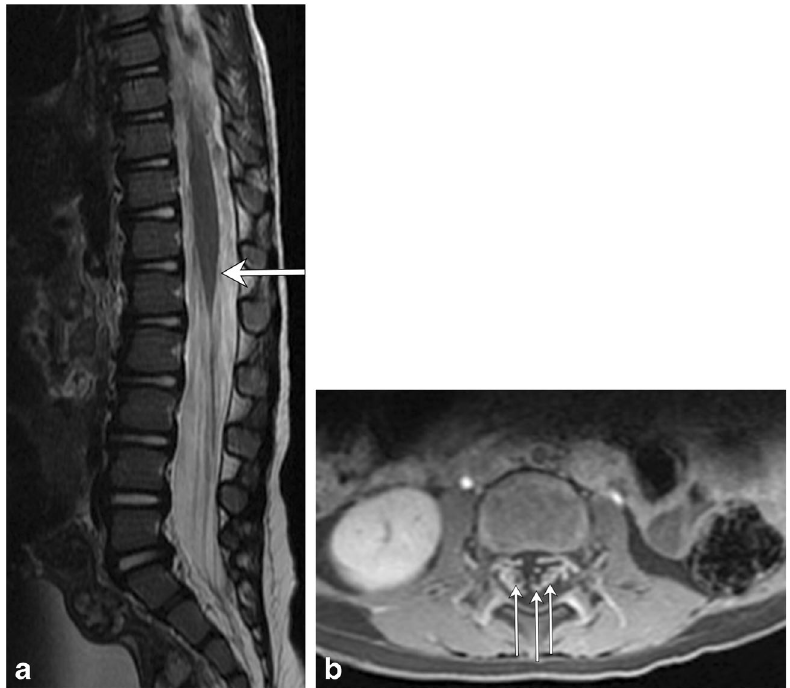
Fig. 8 Guillian-Barré syndrome.